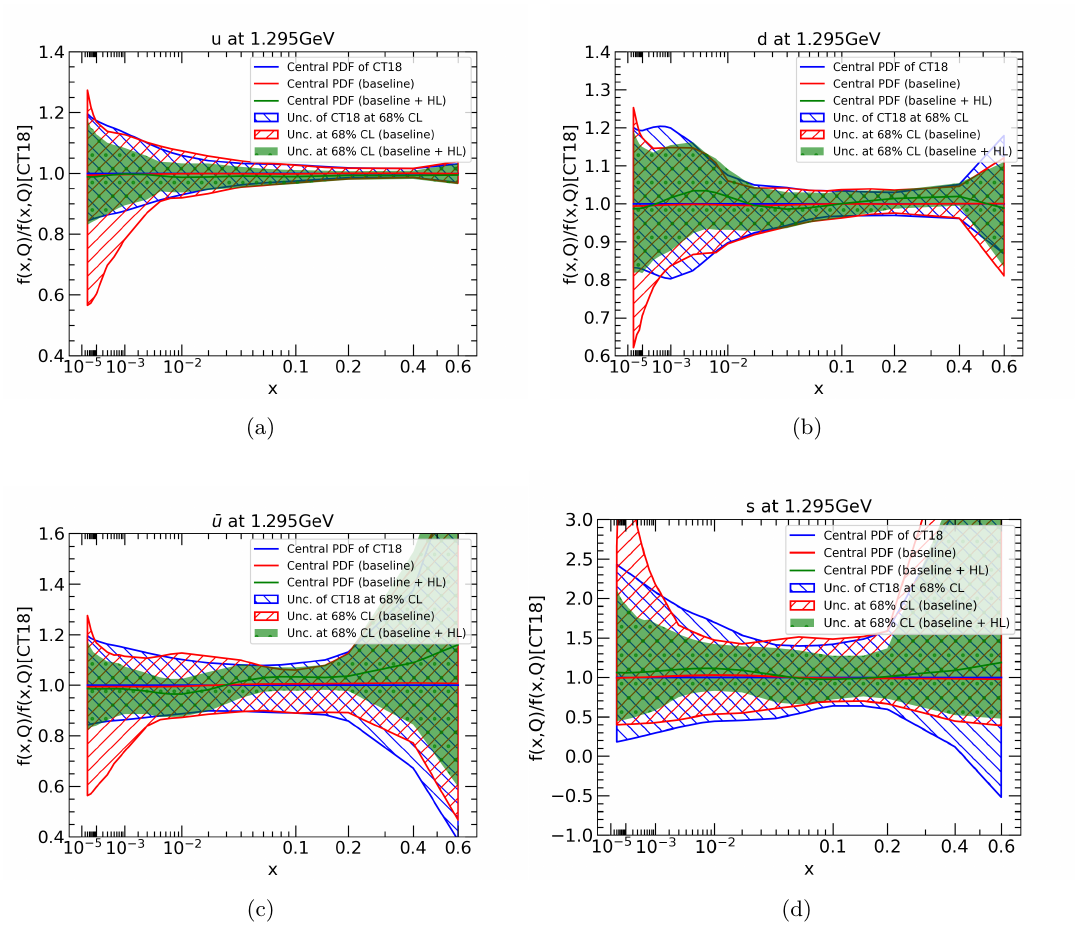
Figure 19 . The parton distribution functions at Q = 1 . 295 GeV for u , d , ¯ u and s . The red and the green solid lines represent the central values without and with HL-LHC pseudo-data respectively, and the red and the green hatched areas represent the respective uncertainties at 68% CL. The results are normalized to the central value of CT18 NNLO (blue solid